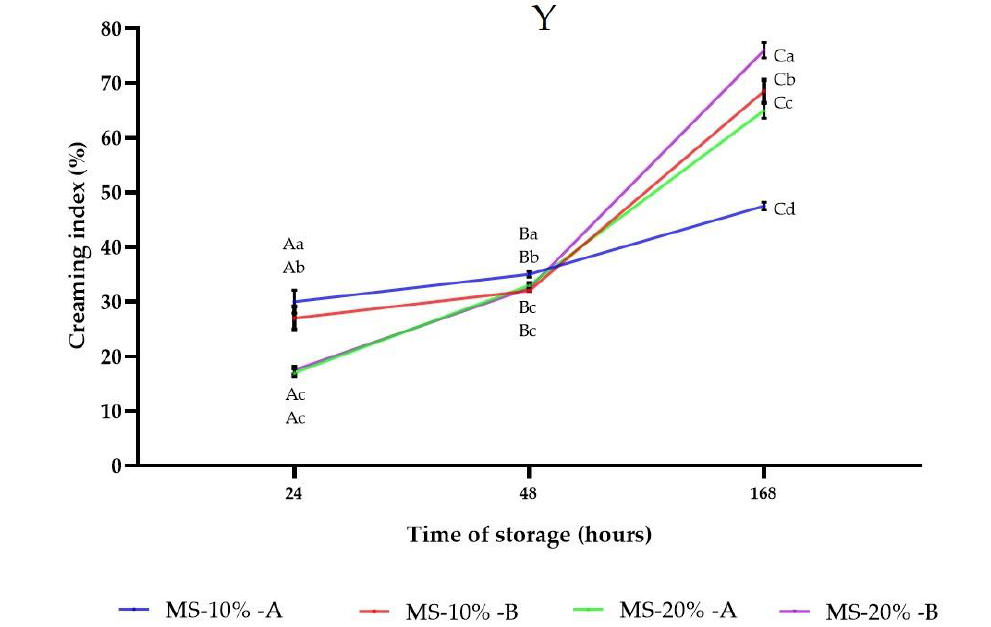
Figure 3. Creaming Index ( CI ) values of samples. ( X ) FOCE-based emulsions before spray drying A and after reconstitution B. Means with different lowercase are significantly different at p < 0.05. ( Y ) Emulsions without FOCE before spray drying A and after reconstitution B. Means with different letters are significantly different at p < 0.05.